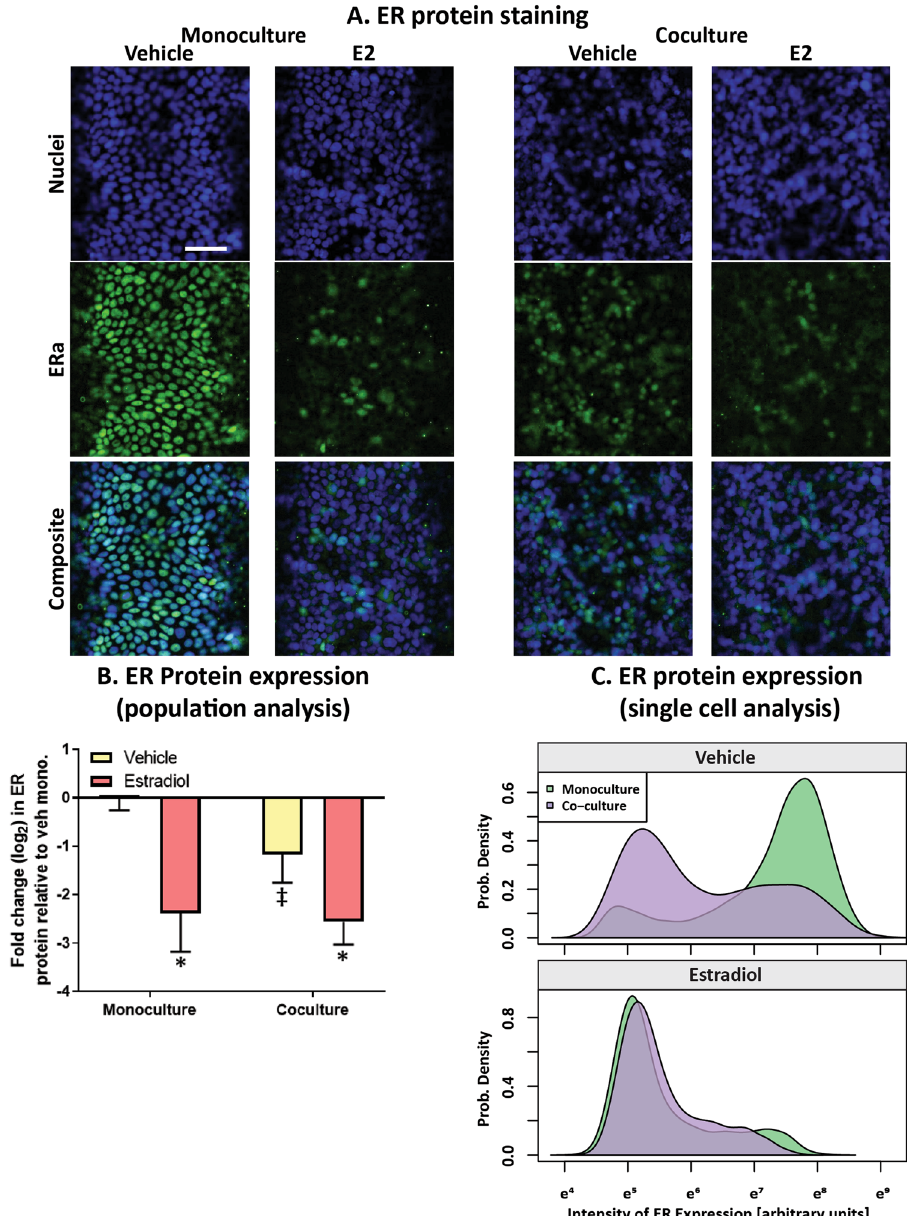
Figure 3. MCF7-derived ducts grown in a mixed collagen:fibroblast matrix express lower levels of ER protein. MCF7-derived ducts were cultured alone or in co-culture with HMFs, treated with a vehicle control or 100 nM E2 for 24 hours. ( A ) Cultures were fixed and stained to visualize nuclei and ER α protein. Scale bar represents 100 μ m. To quantify ER protein, the Hoescht stain was used to generate nuclear masks then ER expression was quantified within each nuclear mask. ( B ) Mean ER expression per condition was graphed to visualize ER protein changes within the entire population. A two-way ANOVA was run to evaluate interactions between conditions, followed by a Tukey’s multiple comparison test to identify significant differences. ( C ) A density plot was created to show the frequency of individual cells (x-axis) that expressed various levels of ER protein (y-axis). * = vs. respective vehicle (p < 0.05) and ‡ = vs. respective monoculture (p < 0.05). Data is representative of three independent